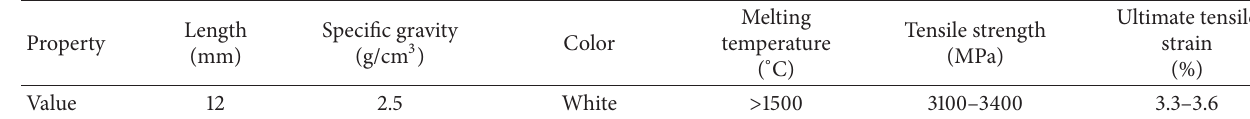
Figure 7: Creep test procedures. Table 3: Physical properties of glass fiber.